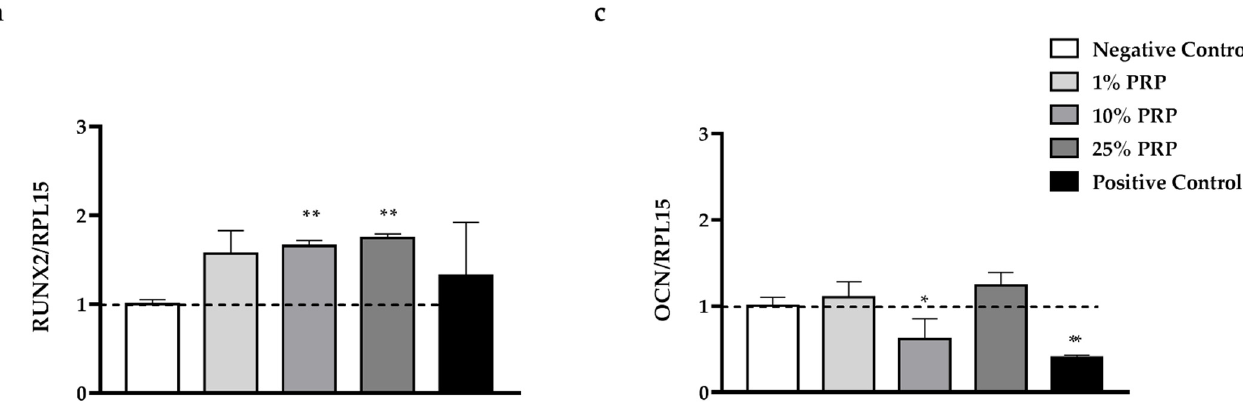
Figure 6. Gene expression of HOB-01-C1 cells at a day 12 after seeding (T12) and treated with different dilutions of PRP (1–25%). ( a ) RUNX2; ( b ) COL1A1; ( c ) OCN; ( d ) PHEX. Each gene was normalized for Ribosomal Protein 15 (RPL15). Data are reported as fold of expression (Fold change) vs. Negative Control and represented as mean ± SD of three independent experiments performed on sample 4. Statistical analysis was performed by one-way Anova. (* p < 0.05; ** p < 0.01; *** p < 0.001). The expression of runt-related transcription factor-2 (RUNX2, Figure 6a), which is considered the master gene of osteogenesis, increased after PRP treatment: the fold-change compared to the negative control was statistically significant after treatment with 10% and 25% dilutions (Fold change vs. Negative Control: 1% PRP: 1.56 ± 0.26, p > 0.05; 10% PRP 1.65 ± 0.06, ** p < 0.01; 25% PRP: 1.74 ± 0.05, ** p < 0.01; Positive Control: 1.32 ± 0.6, p > 0.05). Alpha-1 type I collagen (COL1A1, Figure 6b), whose expression is partially affected by RUNX2, significantly increased in cells treated with 10% PRP (Fold change vs. Negative Control: 1% PRP: 1.15 ± 0.12, p > 0.05; 10% PRP: 4.45 ± 0.16, *** p < 0.001; 25% PRP: 1.16 ± 0.006, * p < 0.05; Positive Control: 1.44 ± 0.11, * p < 0.05). Osteocalcin (OCN, Figure 6c), a gene exclusively expressed by osteoblasts, decreased in both positive control and after 10% PRP treatment, although the latter was not significant (Fold change vs. Negative Control: 1% PRP: 1.10 ± 0.18, p > 0.05; 10% PRP: 0.614 ± 0.24, p > 0.05; 25% PRP: 1.24 ± 0.15, p > 0.05; Positive Control: 0.40 ± 0.03, ** p < 0.01). Finally, the expression of the osteocyte-specific gene PHEX (phosphate-regulating neutral endopeptidase X-linked, Figure 6d) significantly increased in cells treated with 10% PRP, as well as in the Positive Control (Fold change vs. Negative Control: 1% PRP: 1.58 ± 1.1, p > 0.05; 10% PRP: 2.02 ± 0.09, p > 0.05; 25% PRP 0.85 ± 0.66, p > 0.05; Positive Control: 4.25 ± 0.7, * p < 0.05). Taken together these results suggest that 10% PRP is the dilution that strongly promotes the HOB-01-C1 differentiation to a more mature phenotype.